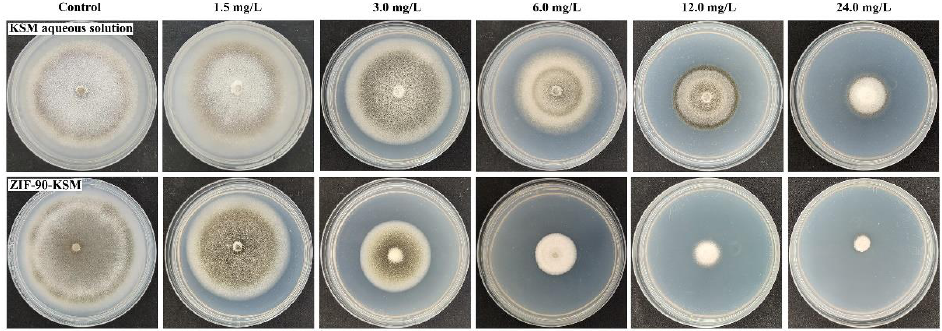
Figure 6. Images of the fungicidal activity of KSM aqueous solution and ZIF-90-KSM against Magnaporthe oryzae .